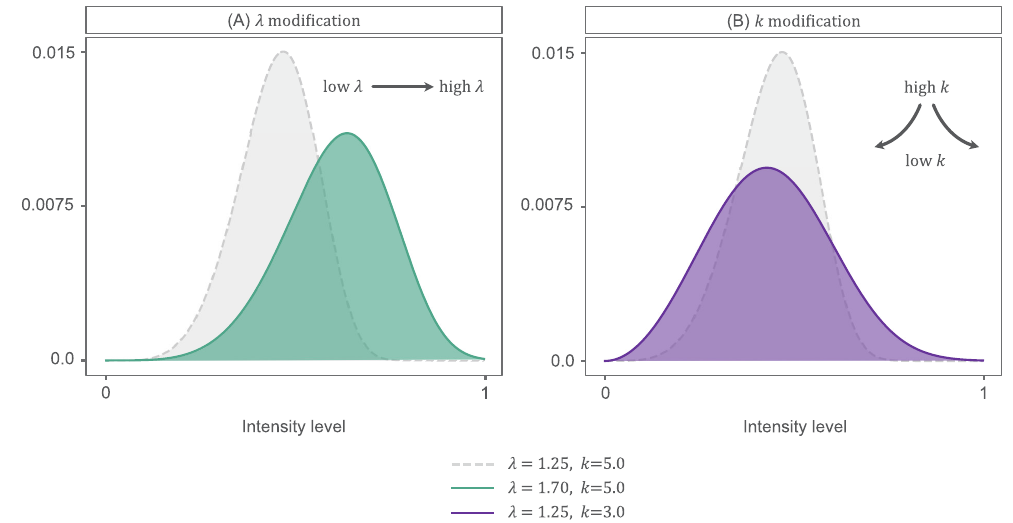
Figure 5. Parameter control over WD properties: ( A ) λ modification and ( B ) k